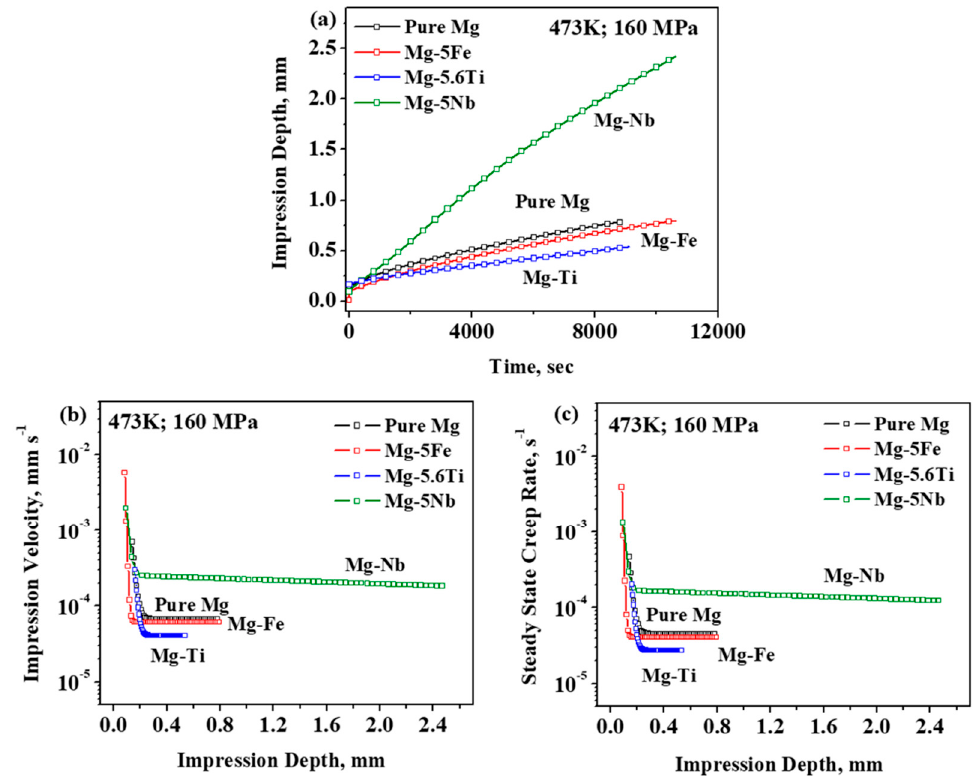
Figure 9. Impression creep curves of pure Mg, Mg-5Fe, Mg-5.6Ti, and Mg-5Nb: ( a ) Variation of impression depth vs. time; ( b ) variation of impression velocity with impression depth; and ( c ) steady state creep rate of the materials.